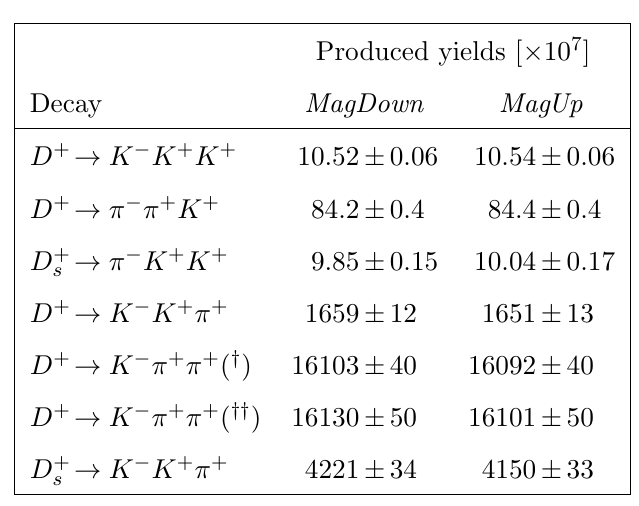
Figure 4 . Invariant-mass distributions of candidates of the normalisation modes (left) D + ! K (cid:0) (cid:25) + (cid:25) + and (right) D + ! K (cid:0) K + (cid:25) + with the corresponding (cid:12)t result superimposed (red s solid line). The blue dotted line corresponds to the signal PDF and the dashed grey line shows the background PDF.